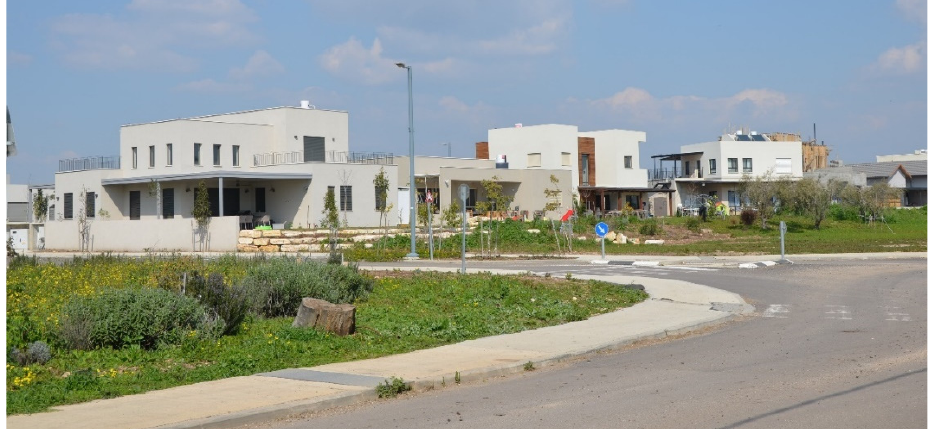
Figure 3. Extension neighborhood at Moshav HaYogev—a suburban image. Photo by the authors.